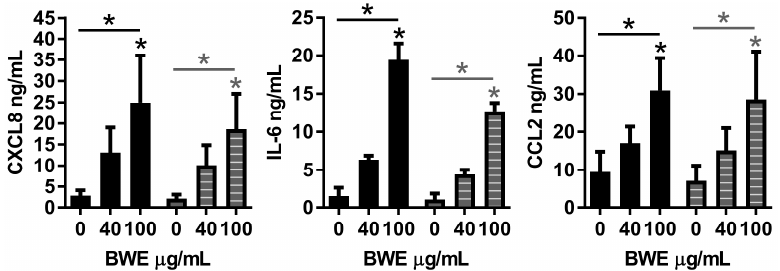
Figure 2. Secretion of inflammation factors by dermal- and adipose-endothelial cells. Secretion of CXCL8, IL-6 and CCL2 after a 24 h exposure to 0, 40 or 100 µg/mL BWE. Basal amounts of protein in culture medium containing 100 µg/mL BWE without cells: CXCL8: <2 ng/mL; IL-6: <1 ng/mL; CCL2: <0.5 ng/mL. Significance of the dose response curve was calculated using a one-way ANOVA followed by a Dunn’s multiple comparison test and significance of basic Fibroblast Growth Factor (bFGF) induction was tested with a t -test; * p < 0.05. Data is shown for 3 independent experiments as mean ± SEM. Each experiment represents a different cell donor and a different BWE donor (see Table 1). Black, solid bars represent dermal-endothelial cells (dermal-EC) and grey, striped bars adipose-endothelial cells (adipose-EC).